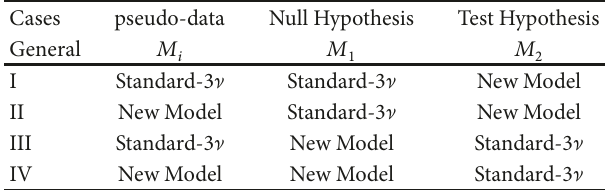
Table2:Descriptionofthepossiblehypothesistakentogeneratethe numerical analysis. Here, Standard-3 ] means standard 3 neutrino oscillation.